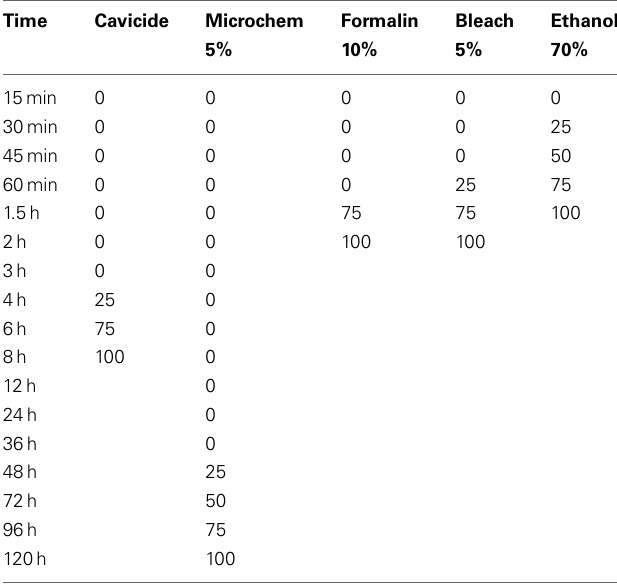
Table 1 | Killing times of Hyalomma marginatum using different